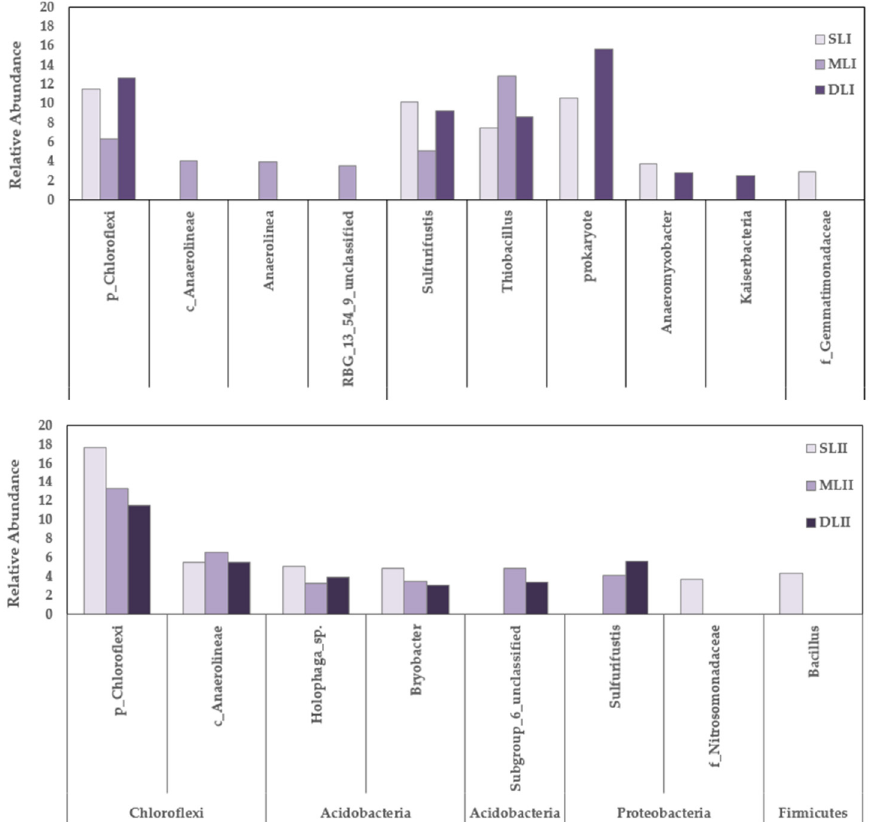
Figure 7 . Relative abundance of the bacterial community composition at the genus level. Figure 7. Relative abundance of the bacterial community composition at the genus